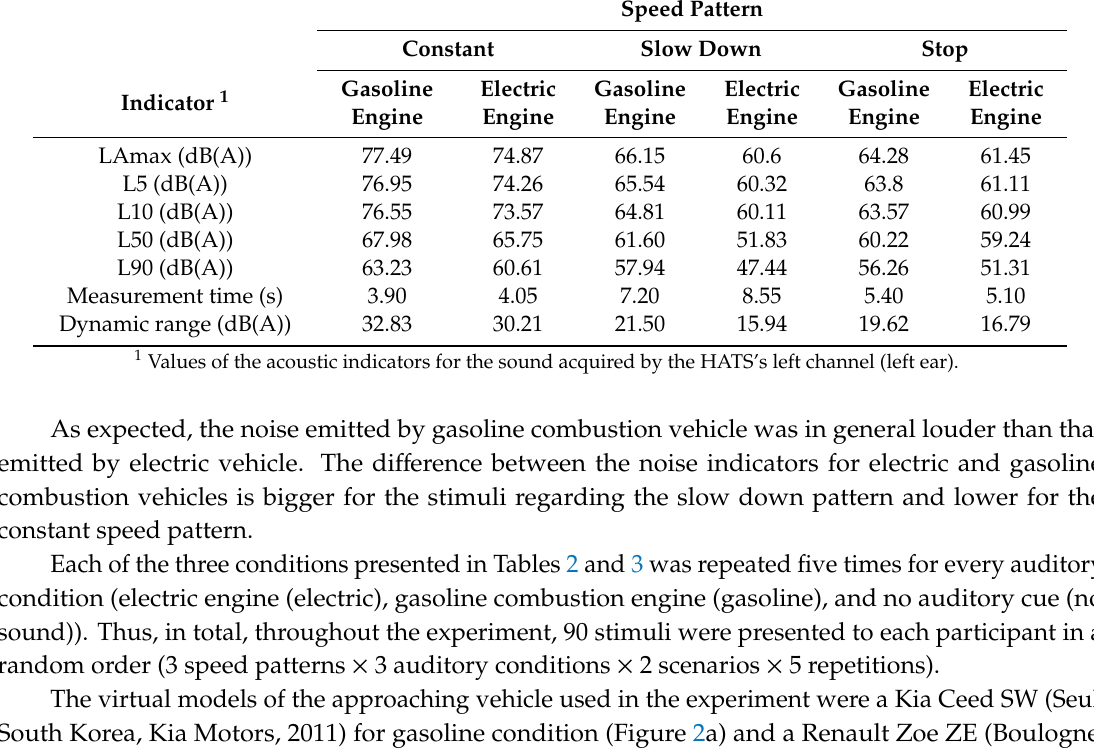
Table 3. Acoustic characteristics of the stimuli regarding the electric and gasoline combustion vehicles.